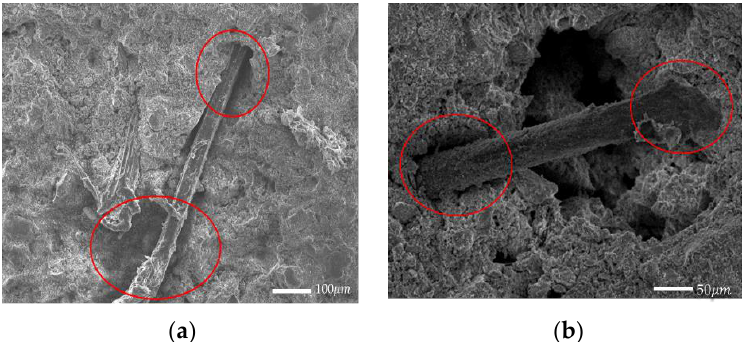
Figure 1 0 . SEM images of fiber and soil-cement matrix interface: ( a ) jute fiber; ( b ) PVA